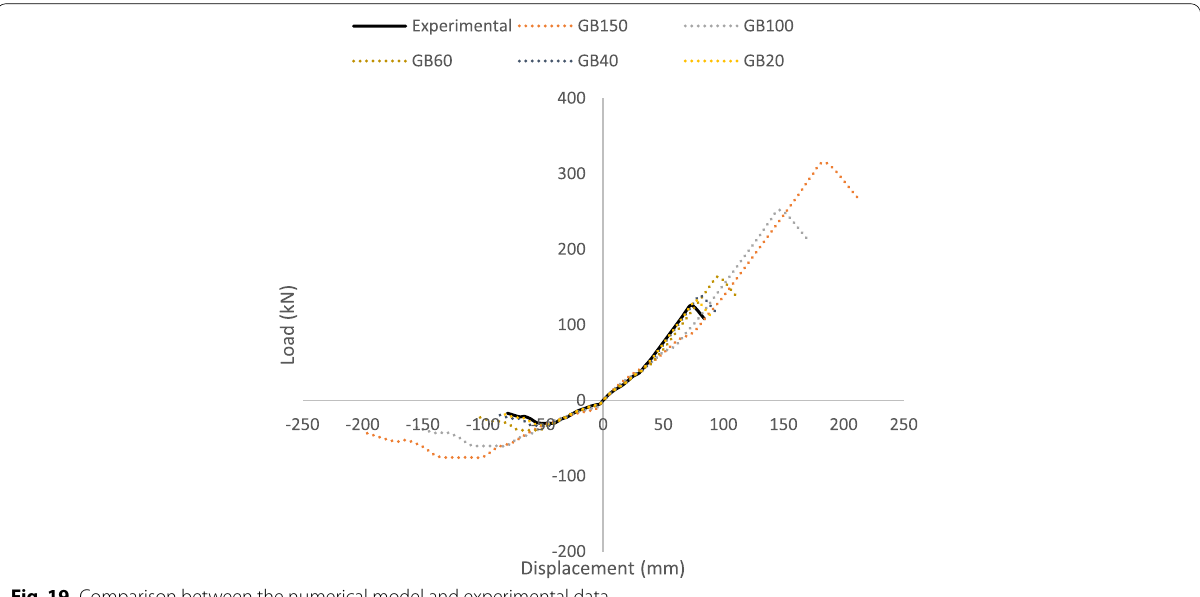
Fig. 19 Comparison between the numerical model and experimental data